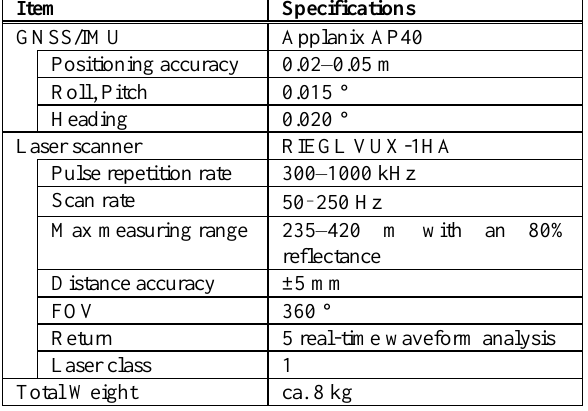
Figure 2. Construction site used as the study area